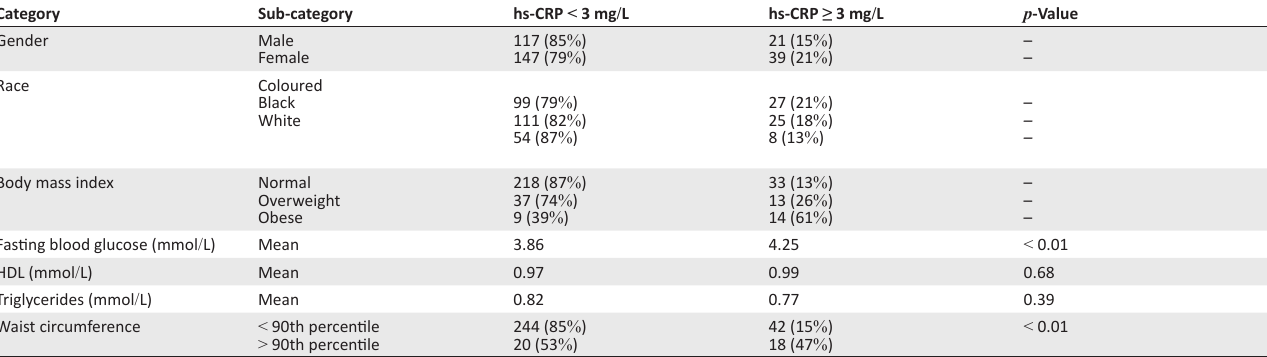
TABLE 3: Baseline demographic data and laboratory results of the study participants ( N =